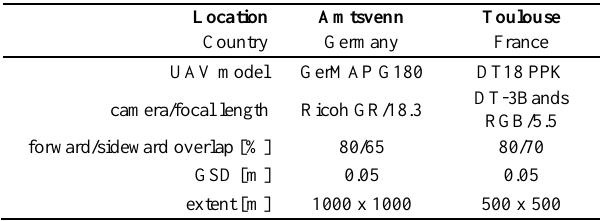
Table 1. Specifications of UAV